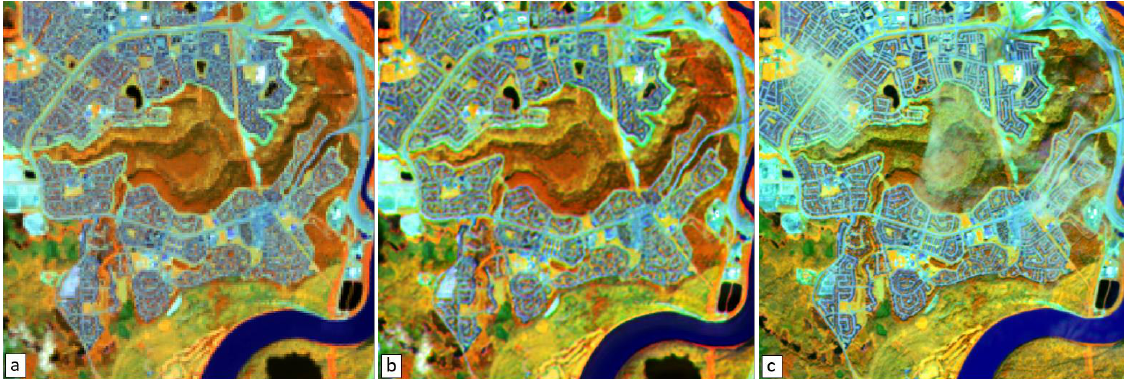
Figure 3. Examples results for a residential area surrounded by mixed boreal forest conditions; ( a ) Landsat image, ( b ) resolution enhanced, and ( c ) Sentinel-2 image. Displayed as red = NIR, green = SWIR, blue = red.